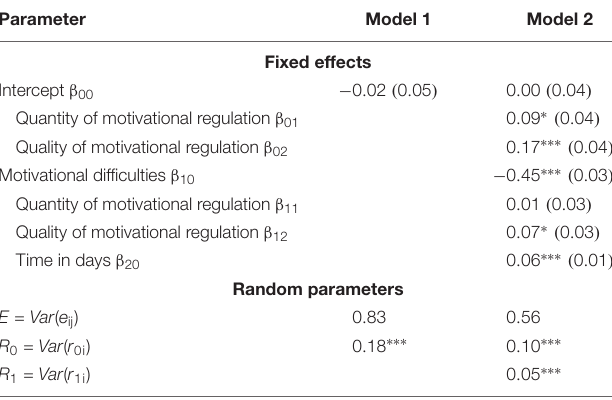
TABLE 2 | Hierarchic linear prediction of invested effort by motivational difficulties and motivational regulation.